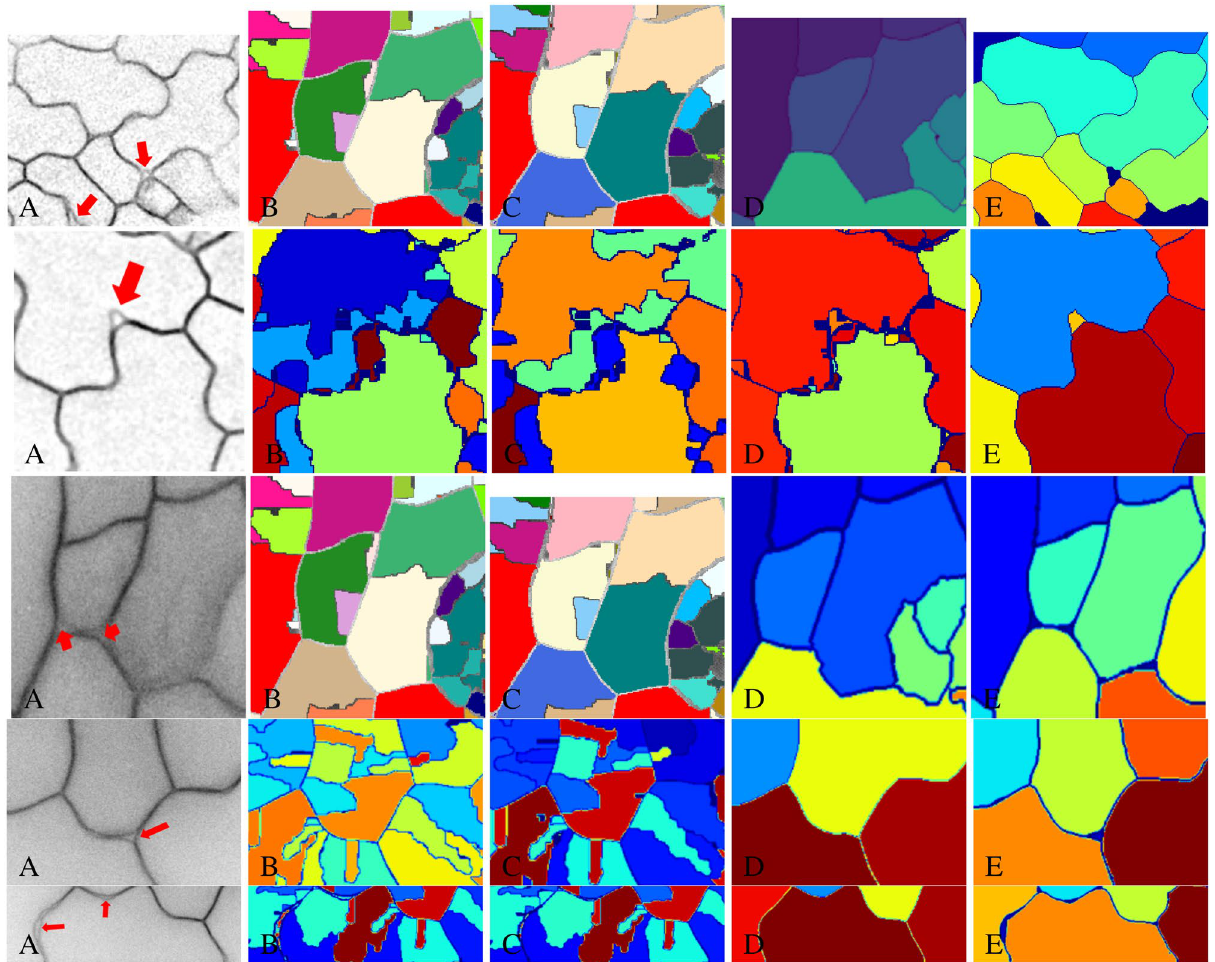
based method, ( E ) proposed